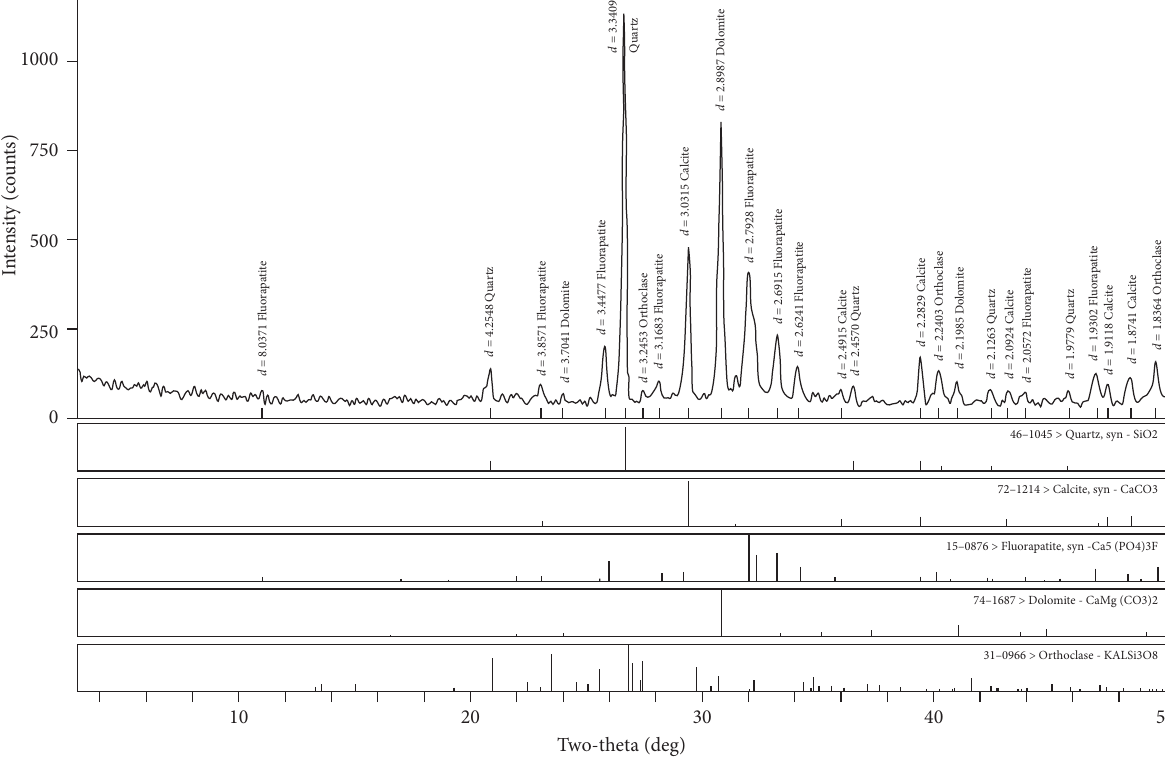
Figure 2: X-ray diffraction spectrum of the sample. Table 2: Mineral composition.